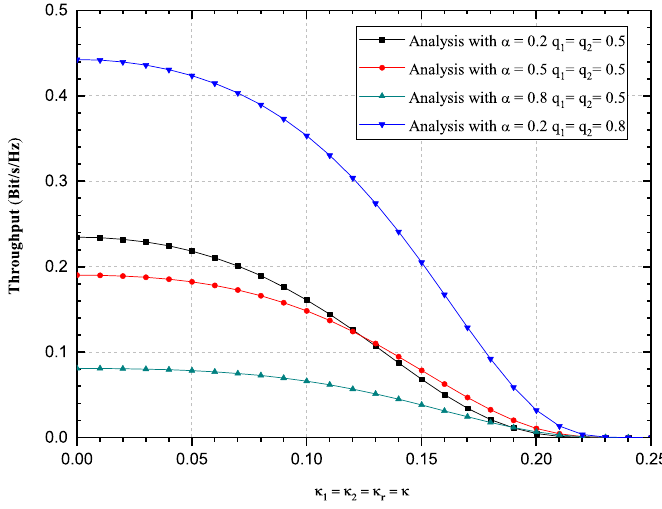
Figure 5. Hoyt fading channels: Achievable throughput versus κ , 2019 IEEE